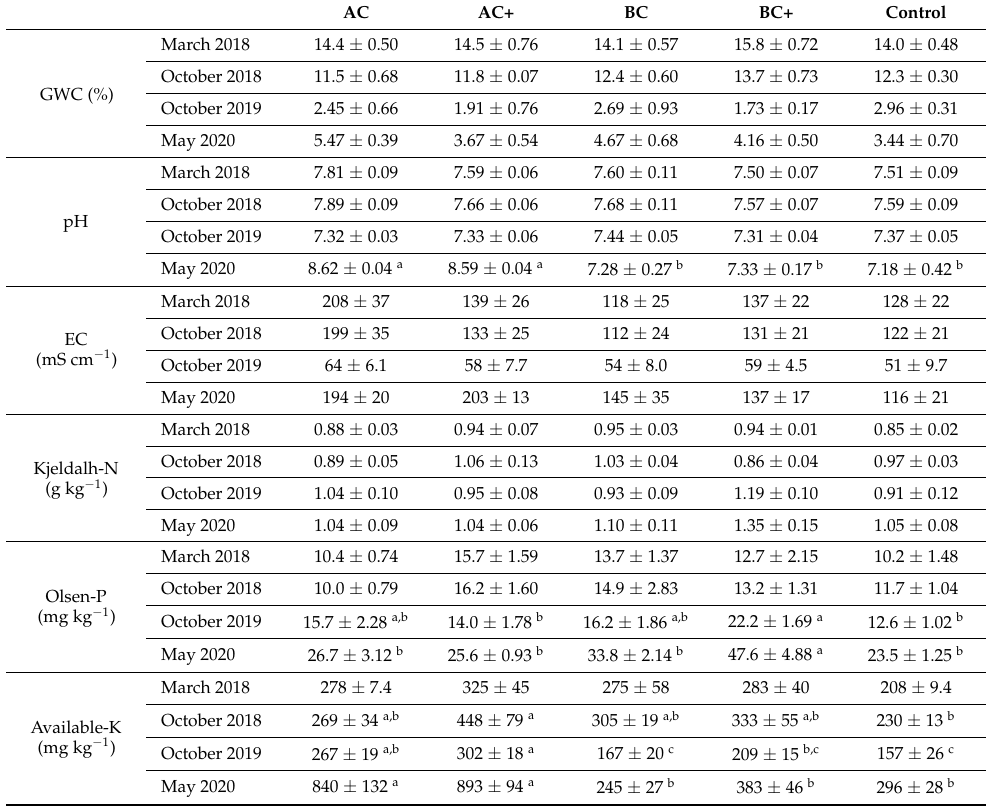
Table 2. Soil parameters during the 3 years of experiments (see Figure S1) under different treatments: AC (alperujo compost), AC+ (high dose of alperujo compost), BC (biosolid compost) and BC+ (high dose of biosolid compost). The same lowercase letters indicate no significant difference ( p > 0.05) between treatments within each year. Data are mean values ± standard error of the mean